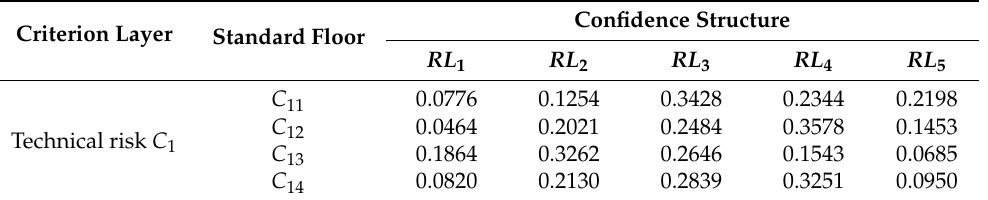
Table 11. Confidence Structure of Technical Risk Indicators.